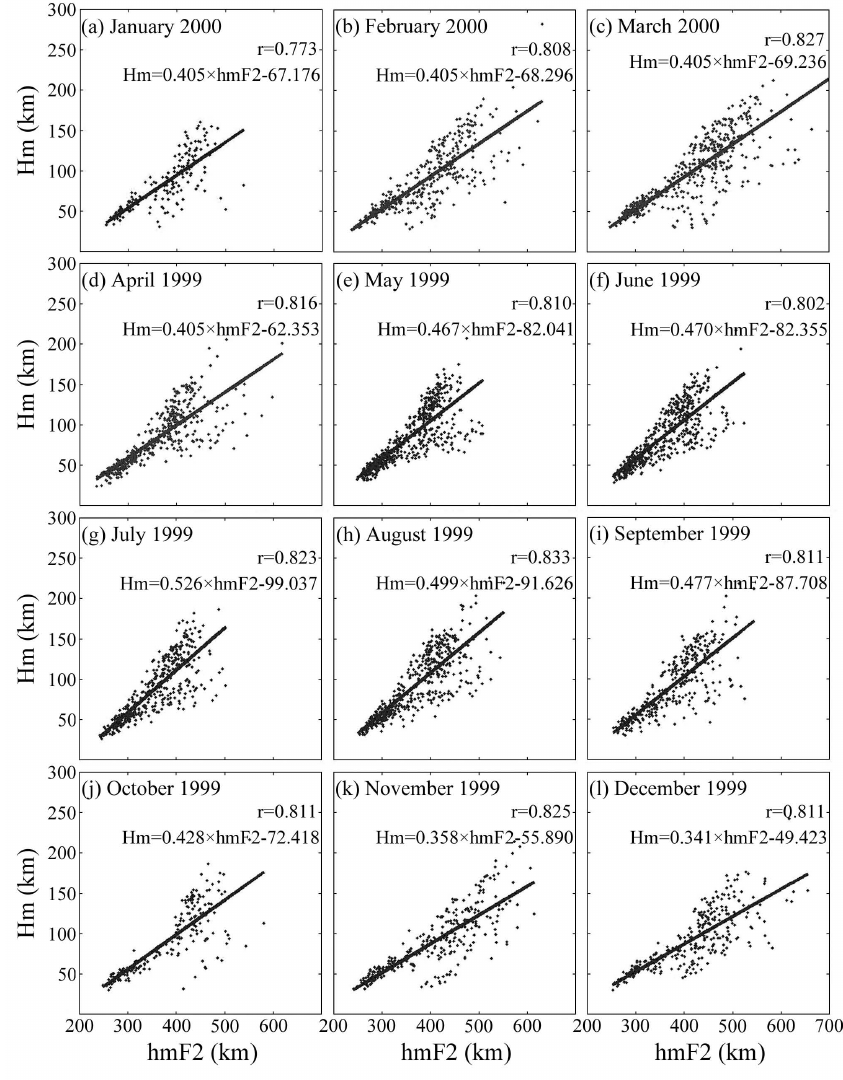
Fig. 7. The scatter plots of Hm versus hmF2 during April 1999–March 2000. The correlation coefficient ( r ) of Hm and hmF2 and the equation of least-squares straight line (solid line) for each month are placed in the upper-right